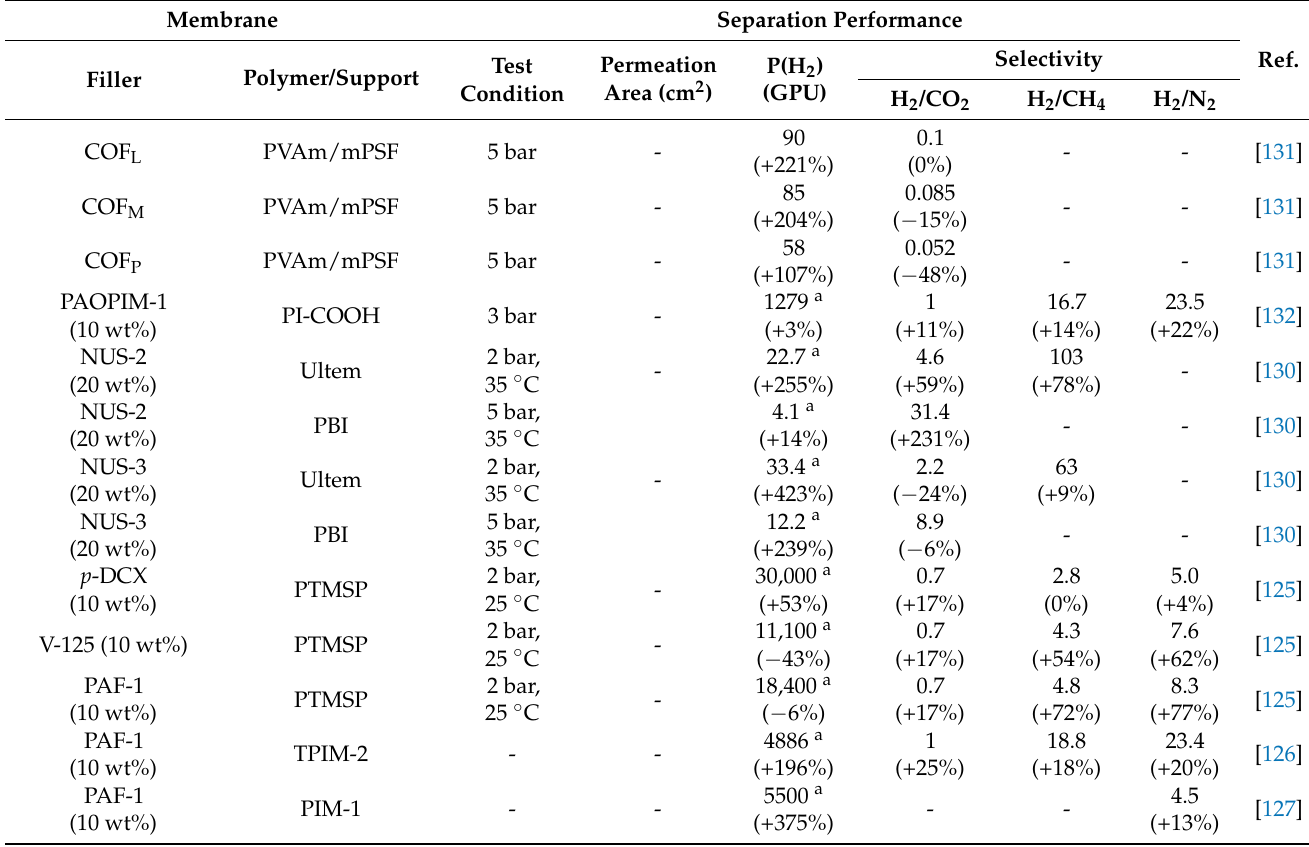
Table 4. Summary of representative performances for COF-based membranes in H 2 -based separation. Membrane Separation Performance